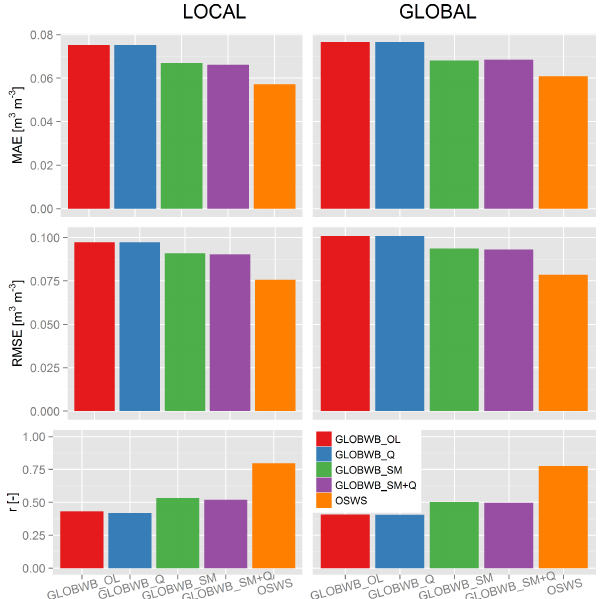
Figure 6. Evaluation results of the catchment daily means of soil moisture in the Murrumbidgee River basin. In the rows, three dif- ferent evaluation metrics are shown; from top to bottom, these are the MAE, the RMSE and r . Columns show various forcing data: local and global. (For clarity, the exact values are included in Ta- ble A1.)